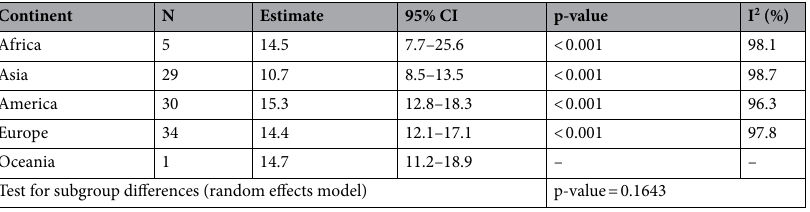
Table 5. Meta-analysis on the prevalence of MIH per continent. MIH Molar-Incisor Hypomineralization, HSPM Hypomineralization of the Second Primary Molars, 95%CI 95% Confidence Interval, FMR female/male